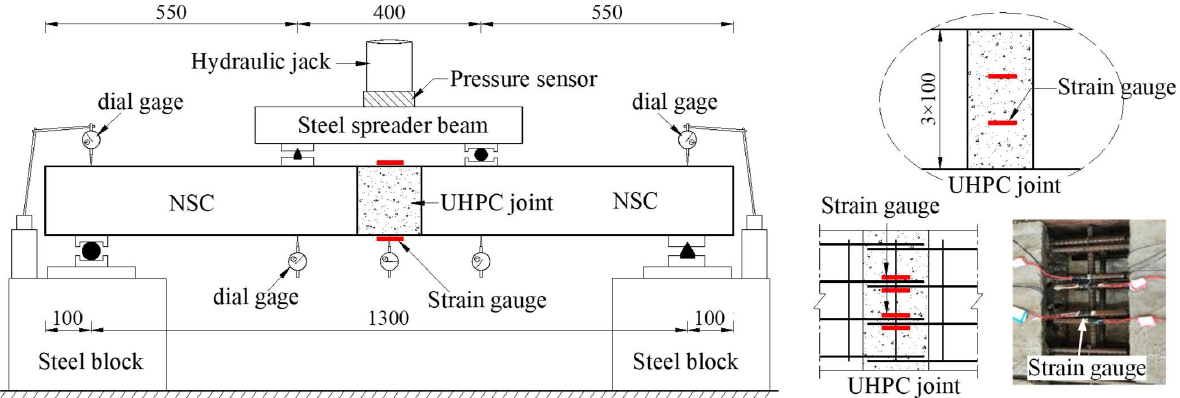
Figure 3. Test setup and arrangement of measuring points.